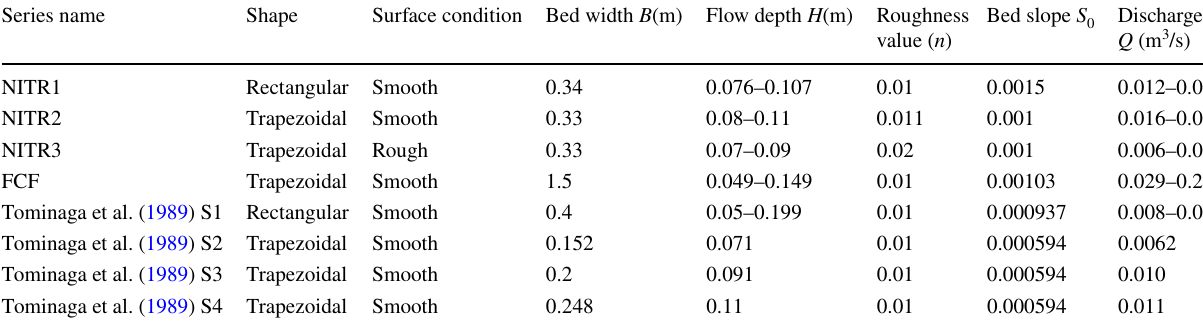
Fig. 2 Fabricated experimental channels of NITR a rectangular, b trapezoidal (Test section is only main channel) Table 1 Details of geometric and hydraulic parameters of the experimental